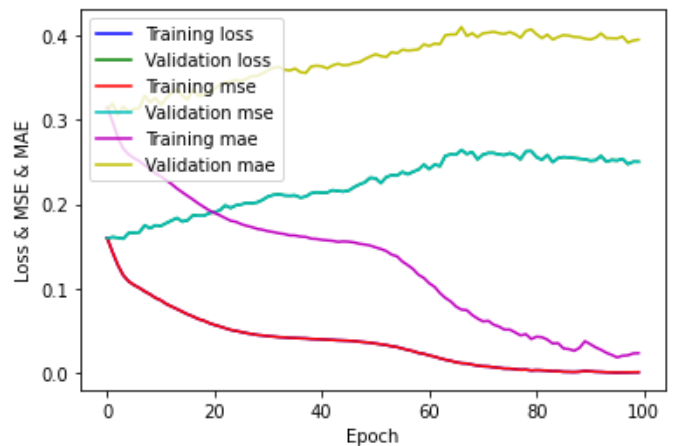
Figure 21. Loss/MSE/MAE plot for training/validation sets of the phase-only image dataset. Table 12. Evaluation metrics for test set on phase-only image dataset.